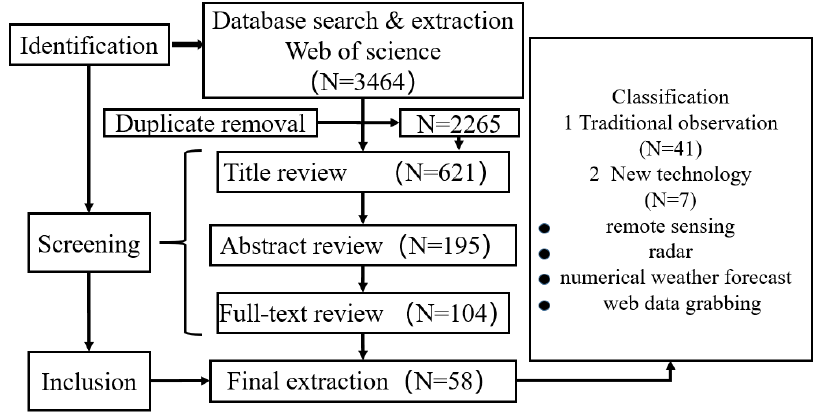
Figure 2. Review structure of literature search and selection.